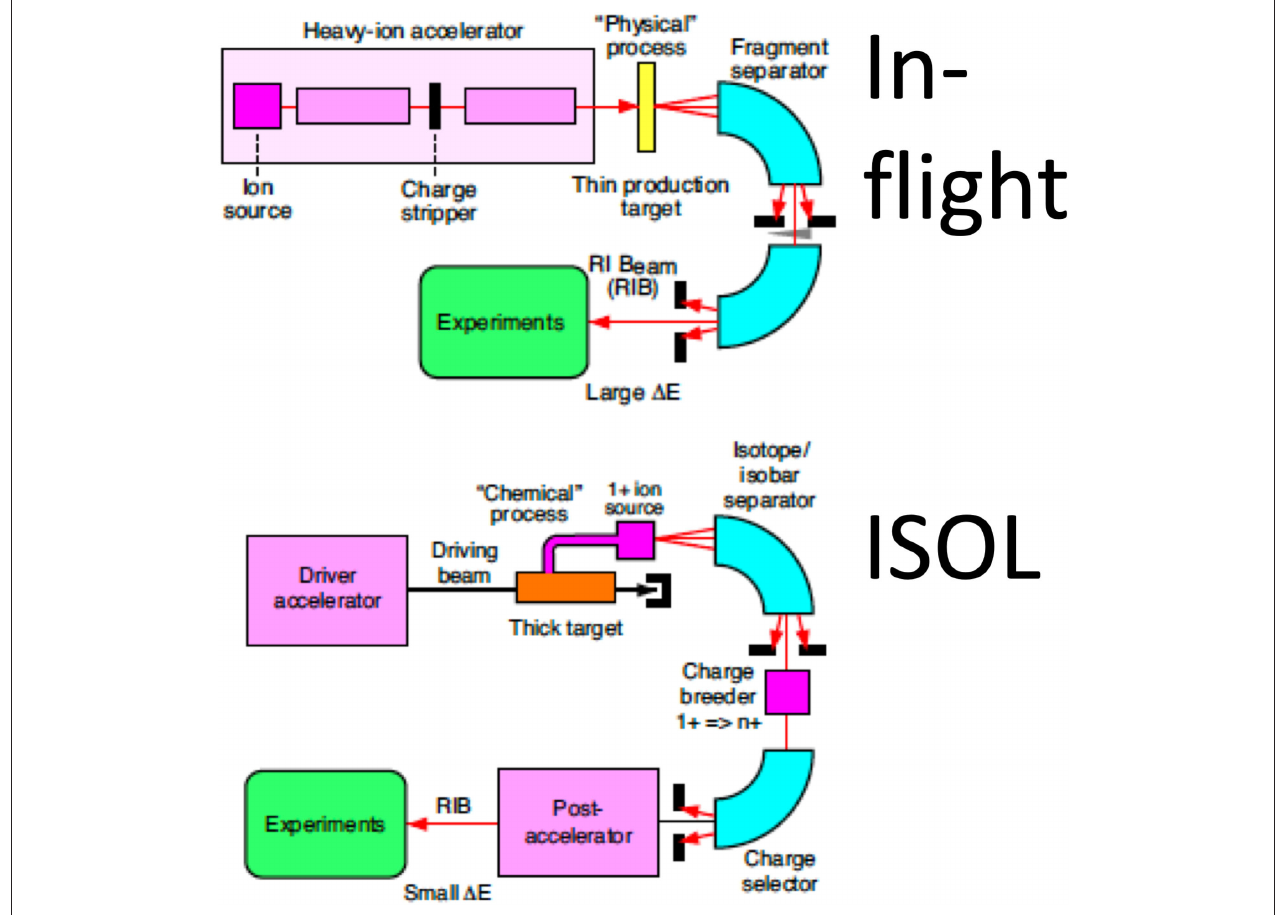
FIGURE 7 | Schematic drawing of the in-flight and ISOL methods for RIB production.